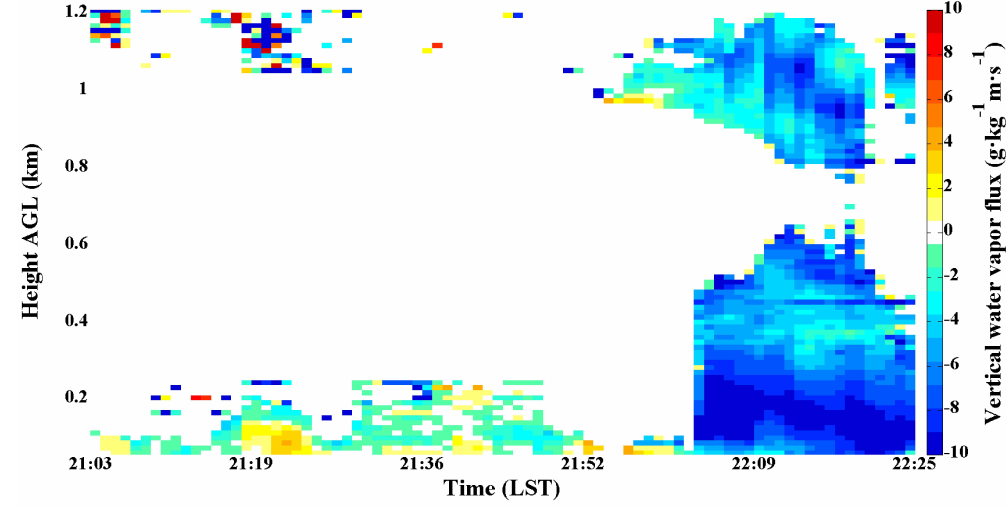
Figure 10. Time serials of vertical water vapor flux from 21:03 to 22:25LST.